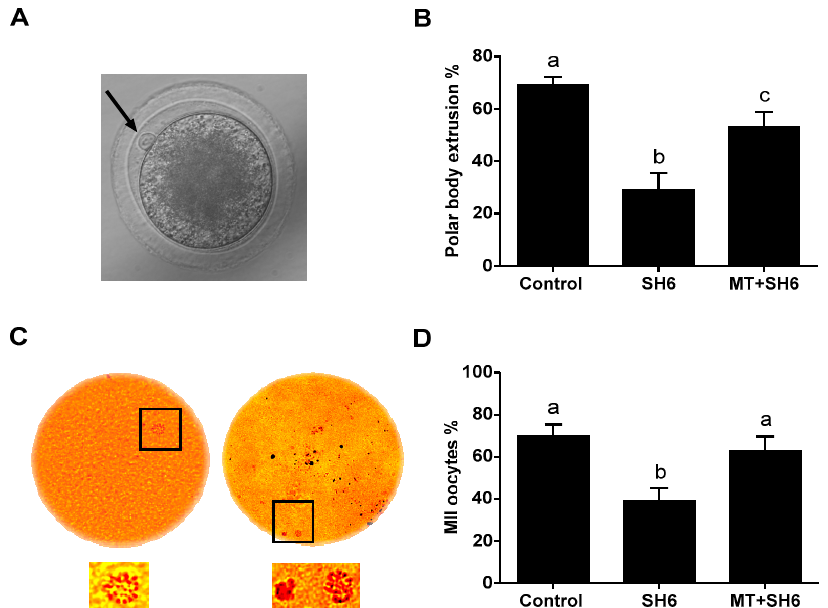
Figure 3. Microscopic determination of oocyte maturation using direct counting of polar body under light microscope or after aceto-orcein staining. ( A ) Appearance of first polar body (Black arrow) in in vitro matured oocyte under stereomicroscope; ( B ) Percentage of oocytes with obvious polar body. For confirmation, oocytes stained with aceto-orcein before examination under epifluorescence microscope; ( C ) The appearance of MI (to the left) and MII (to the right) stages oocytes. The lower parts are zooming for the area labeled with the black squares; ( D ) Percentage of MII-stage oocytes. Original magnification 200 × .